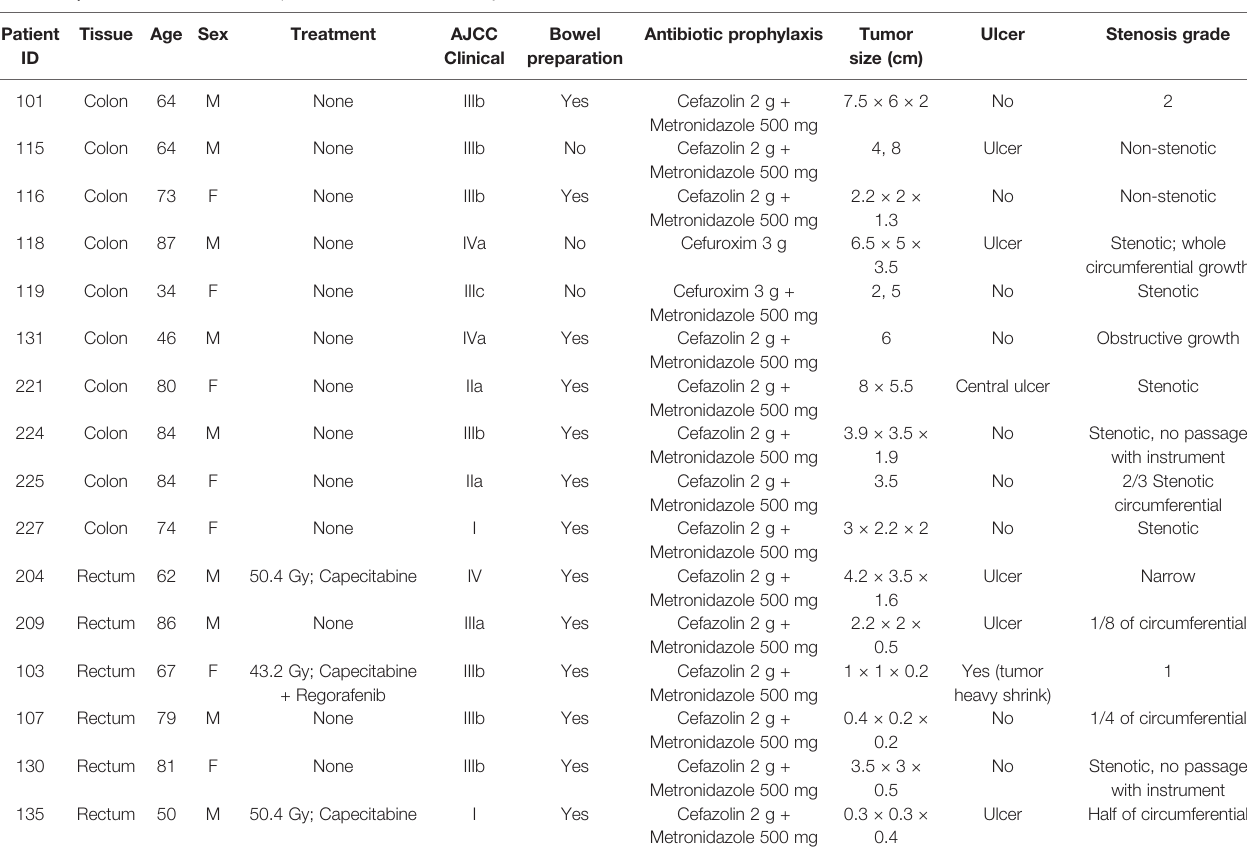
TABLE 1 | Clinical information of the patients included in the study. Patient